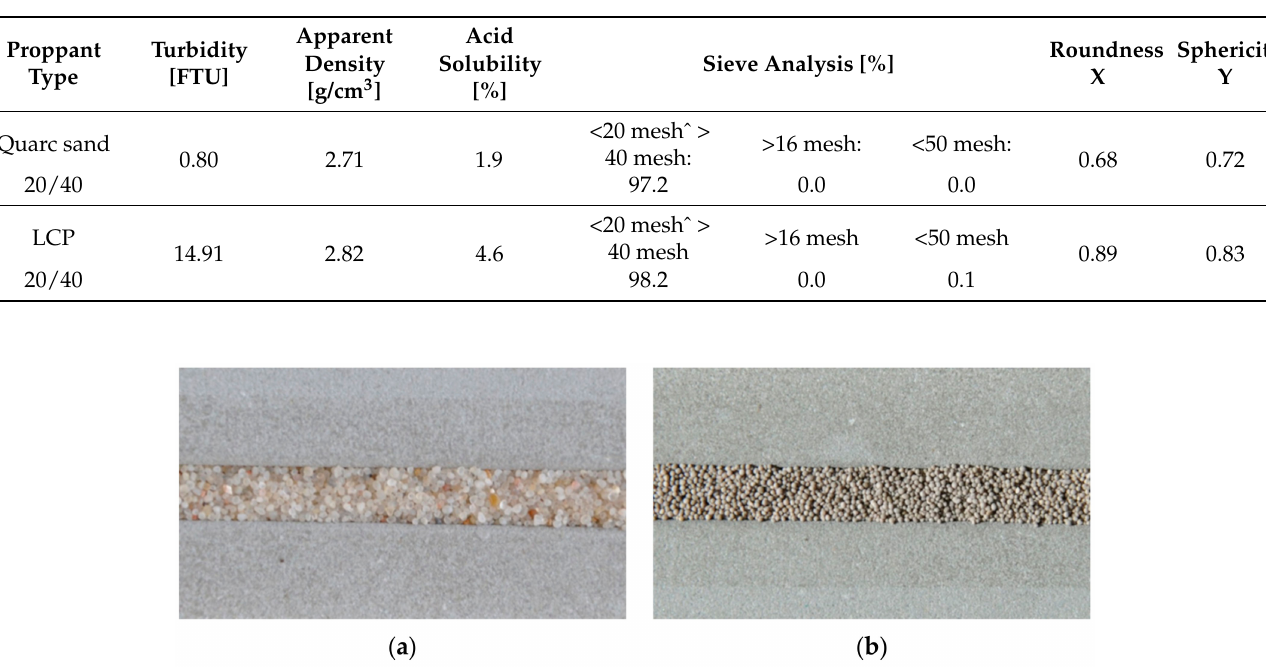
Table 3. Data of proppant basic parameters.